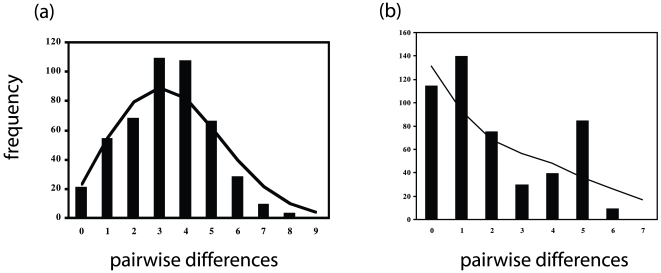
Mismatch distribution for haplotypes observed in harpy eagle samples from (a) South America and (b) Central America.The expected distribution of pairwise genetic distances among haplotypes under a model of sudden expansion are shown as a line and the observed distances are shown as vertical bars.